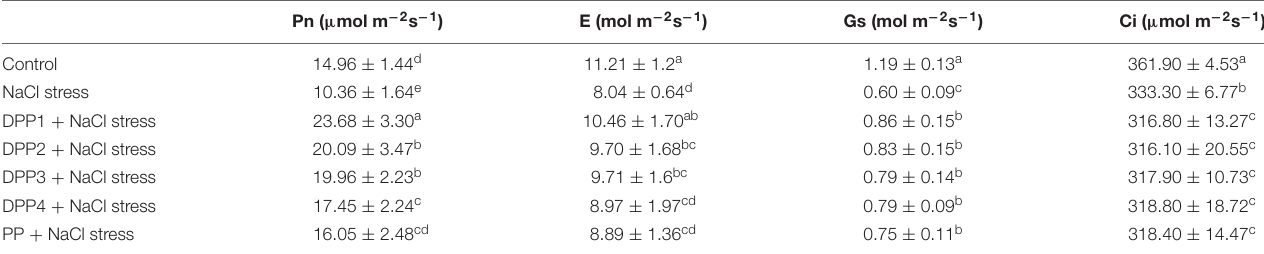
Values are mean ± SD of 10 replicates. Different letters indicate significant differences at P <